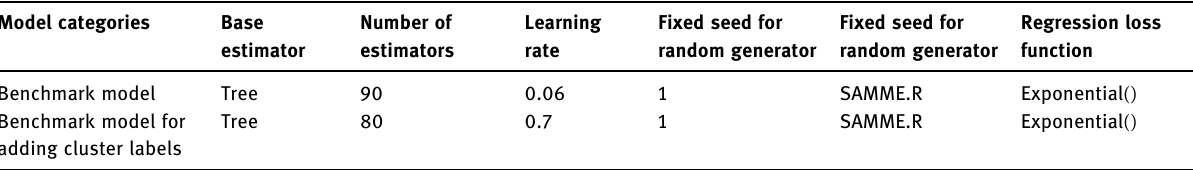
Table 4: Model hyperparameter optimization